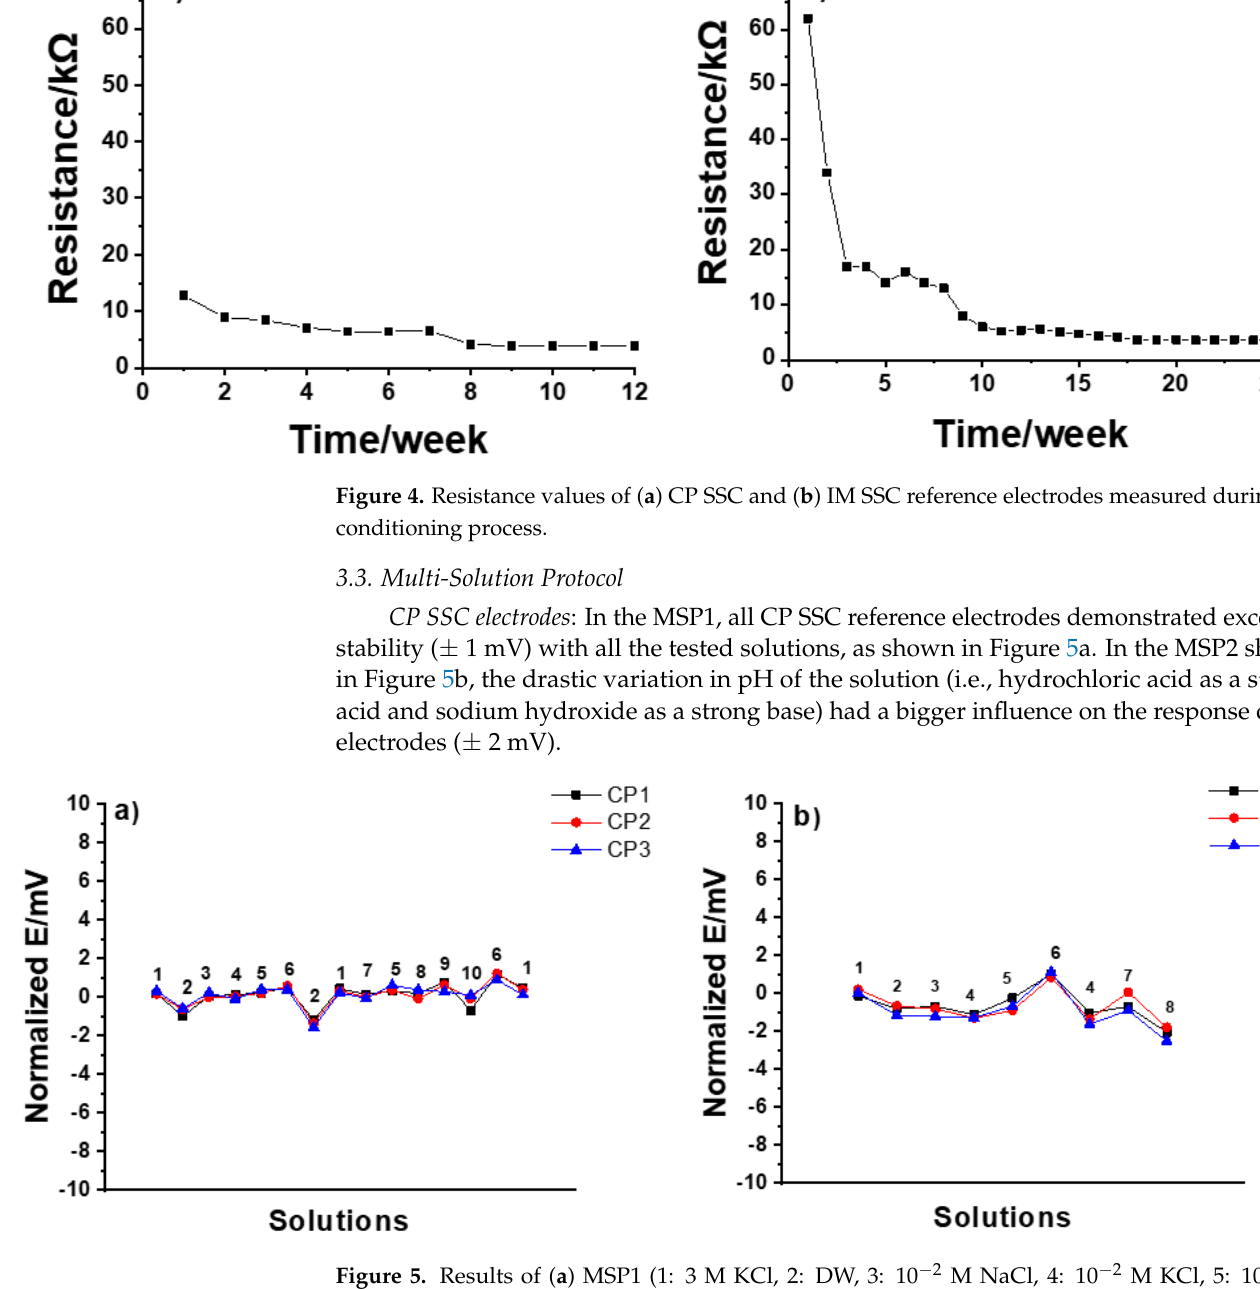
Figure 3. Typical impedance spectra of CP SSC and IM SSC reference electrodes recorded after 5 and 10 weeks of conditioning, respectively.